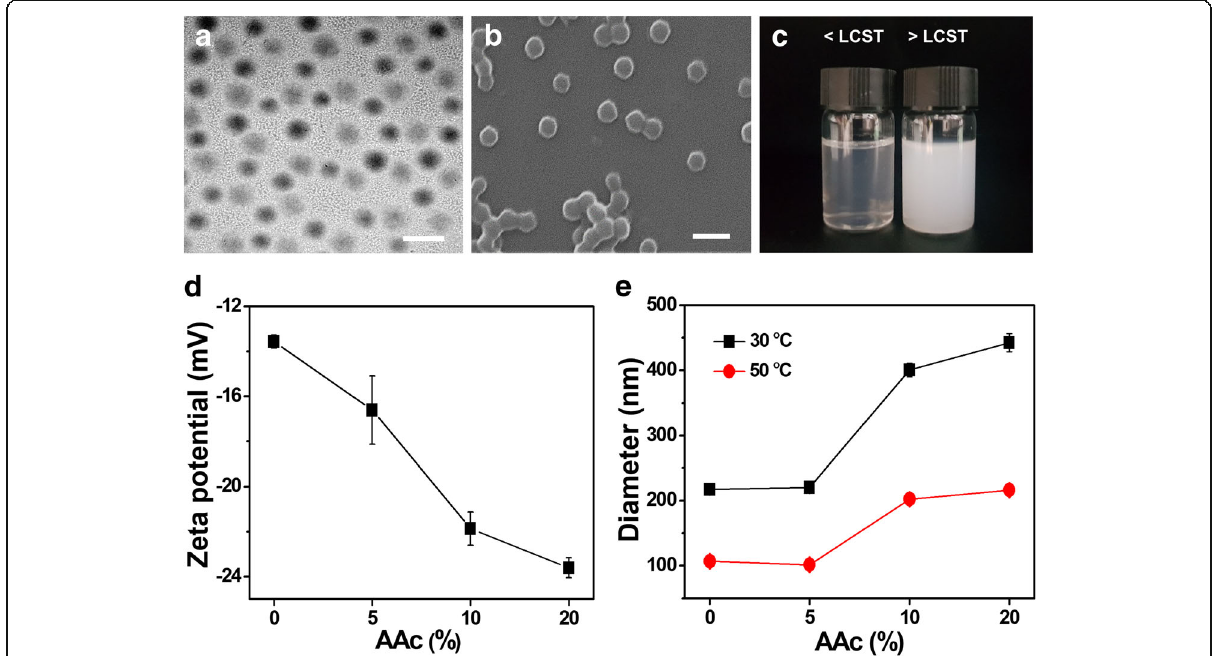
Fig. 1 a TEM and b SEM image of PNIPAM-co-AAc5 nanogels. c Physical appearance of PNIPAM-co-AAc5 nanogels. Scale bars are 500 nm. d Zeta potentials and e average diameters measured at 30 °C and 50 °C by DLS for PNIPAM with 0%, 5%, 10%, and 20% AAc contents at pH 7.4